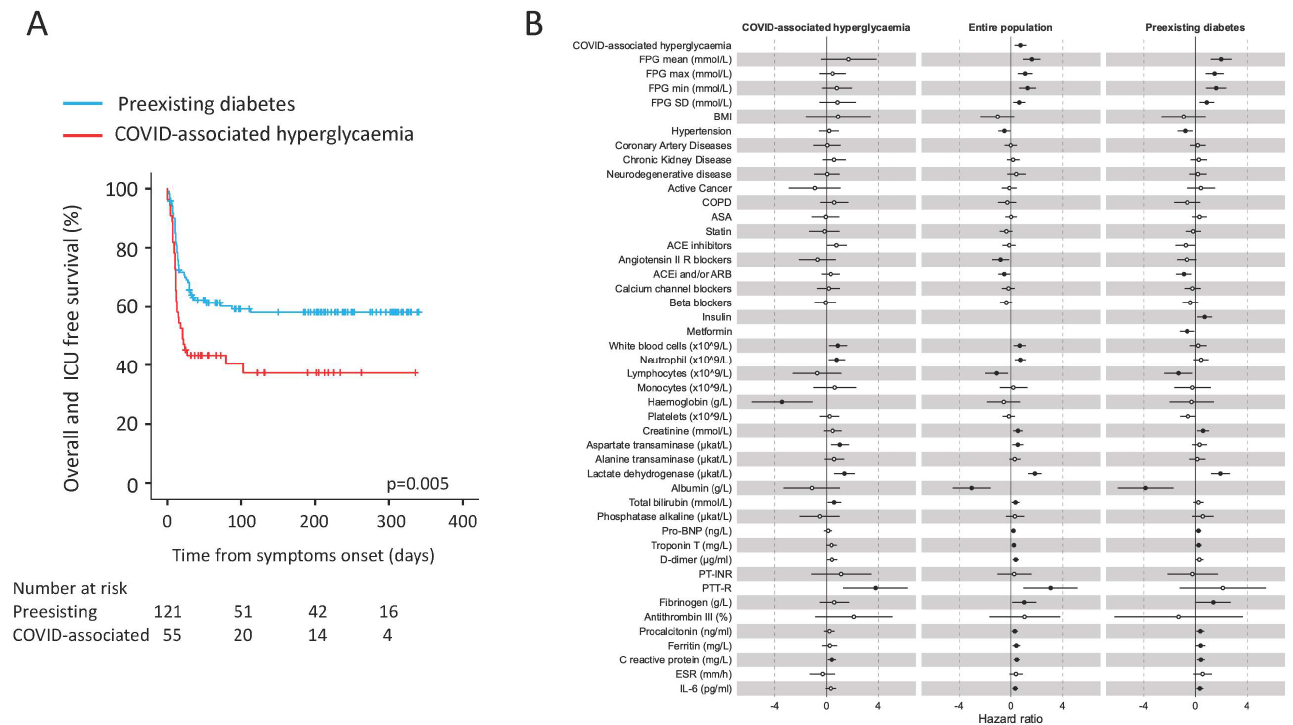
Figure 1. ( A , B ) Adverse clinical outcome in patients with Sars-CoV-2 infection with either pre-existing diabetes or COVID-associated hyperglycaemia. Kaplan–Meier estimates of survival without adverse clinical outcome for 176 patients with COVID-19 pneumonia ( A ). Survival without adverse clinical outcome (defined by composite endpoint of admission to ICU or death, whichever occurred first) was estimated for patients with COVID-associated hyperglycaemia ( n = 55) or pre-existing diabetes ( n = 121). The log-rank test was used to test differences between the two groups. Crosses indicate censored patients (censoring for death or end of follow-up). The forest plots ( B ) show the hazard ratios for survival without adverse clinical outcome according to presence of new-onset or pre-existing diabetes. Univariate Cox regression analysis adjusted for sex and age. Dots represent the HR, lines represent 95% confidence interval (CI), and solid dots indicate p < 0.05.